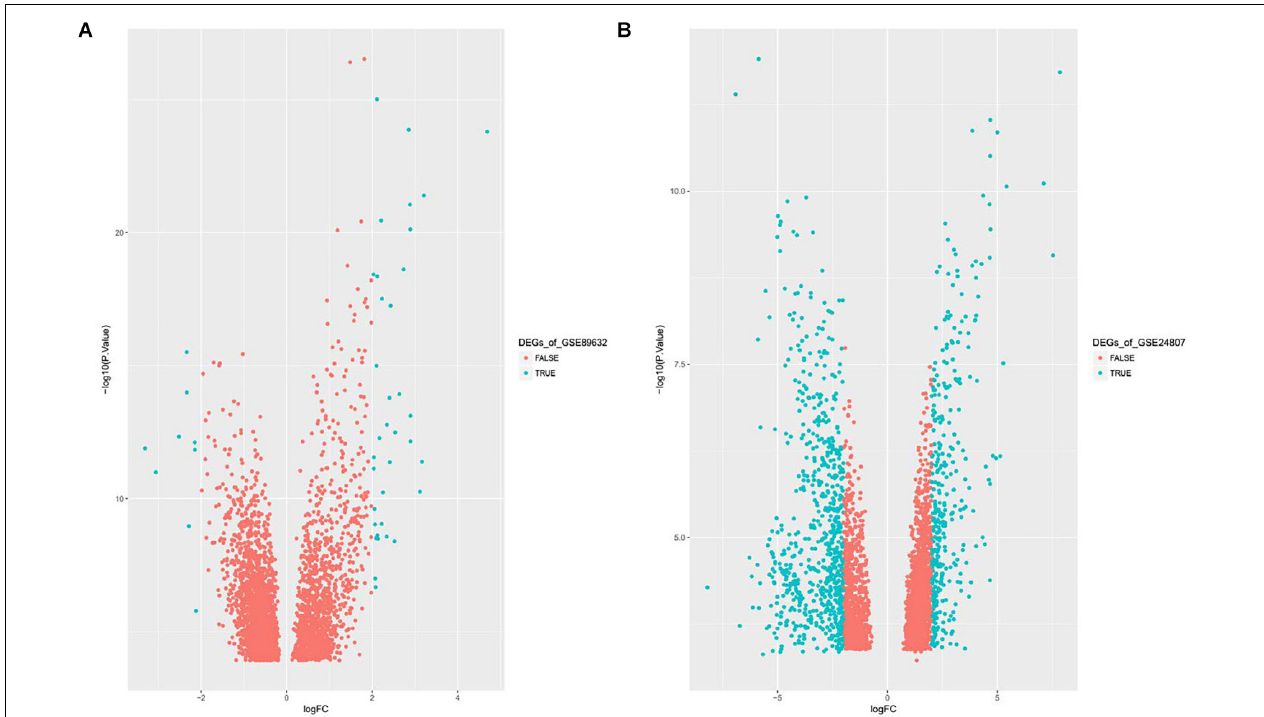
FIGURE 3 | (A) Displays Volcano plot of DEGs of GSE89632, DEG: DEGs. (B) Displays Volcano plot of DEGs of GSE24807, DEG: DEGs.